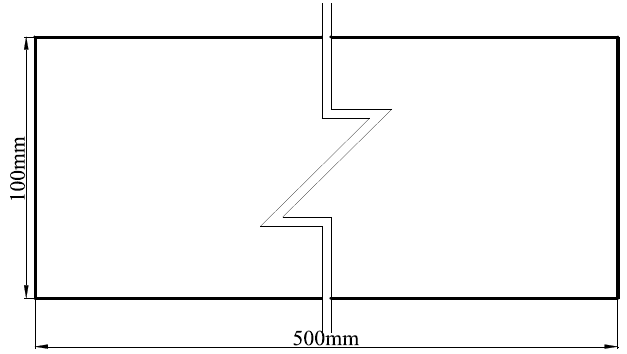
Figure 3. Precast block size of main roof.